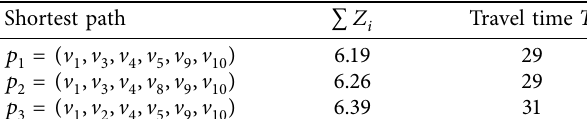
Table 6: Shortest paths.